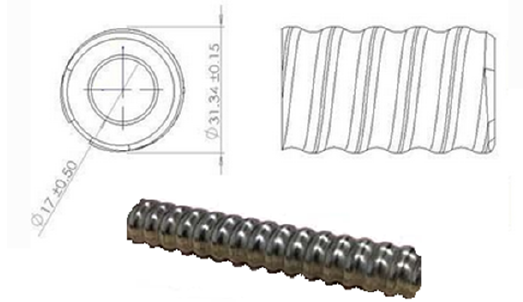
Figure 3. Micropile from steel hollow rod of a spindle shape casing (type R32).